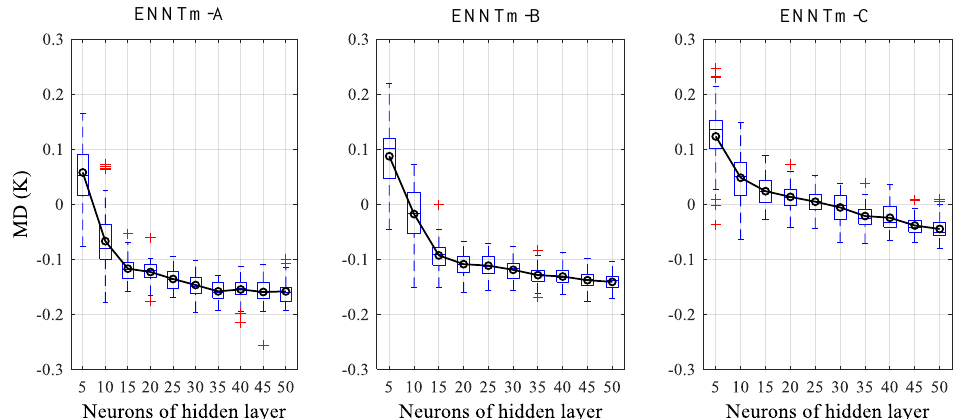
Figure 3. Box-whisker plot of MD for different modeling schemes with different BPNN structures. The small circle denotes the results after combination, the red ‘+’ is the outlier.